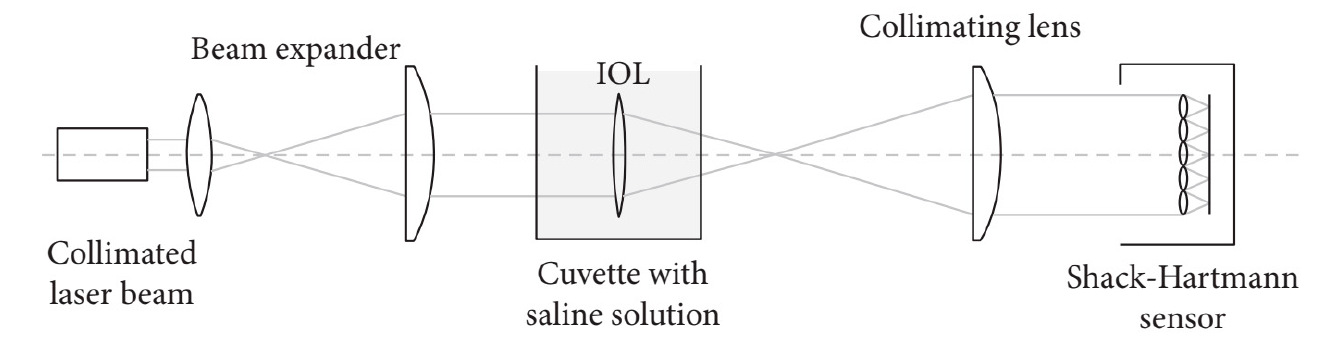
Figure 13. Scheme of a simple optical setup for the measurement of wavefront aberrations. Figure reprinted from Ref. [76] under the terms of the Creative Commons Attribution License.